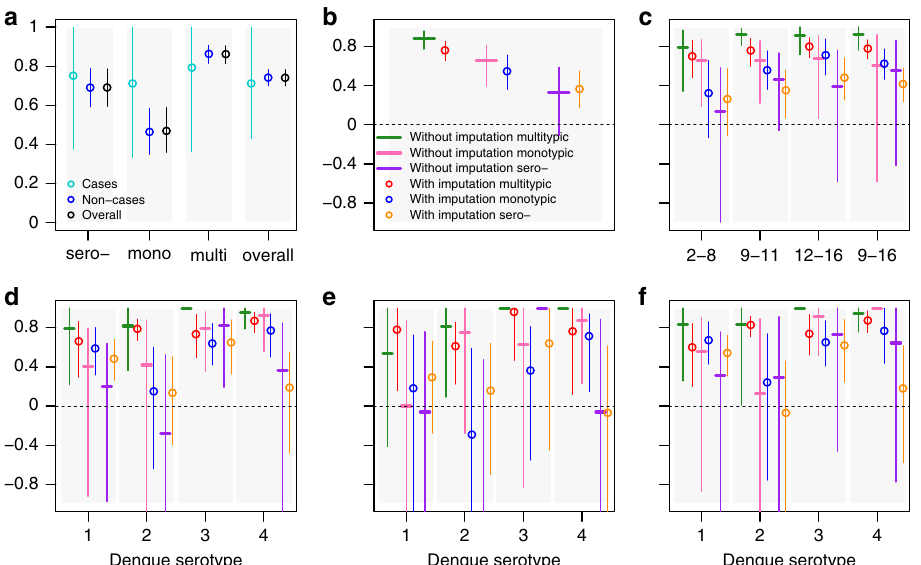
Fig. 2 Mean and 95% CI of vaccine ef fi cacy estimates with and without imputations for subjects with baseline seronegative, monotypic and multitypic PRNT50 titre pro fi les. Estimates were obtained from 1000 realisations of the fi nal BRT model achieving at least 30% accuracy for cases and non-cases, trained on 75% of non-cases and 75% of cases and using fi ve-fold cross-validation, tc = 15, lr = 0.001, bf = 0.75. a Proportion of correct classi fi cations among seronegative (sero − ), monotypic (mono), multitypic (multi) and overall (i.e. seronegative, monotypic and multitypic) cases, non-cases and overall (cases and non-cases). b Vaccine ef fi cacy estimates for baseline multitypic, monotypic and seronegative subjects separately. c Vaccine ef fi cacy estimates for baseline multitypic, monotypic and seronegative subjects by age, using 2 – 8, 9 – 11, 12 – 16 and 9 – 16 years age-groups. d Vaccine ef fi cacy estimates by serotype for baseline multitypic, monotypic and seronegative subjects over all ages (2 – 16 years). e Vaccine ef fi cacy estimates by serotype for baseline multitypic, monotypic and seronegative subjects 2 – 8 years old. f Vaccine ef fi cacy by serotype for baseline multitypic, monotypic and seronegative